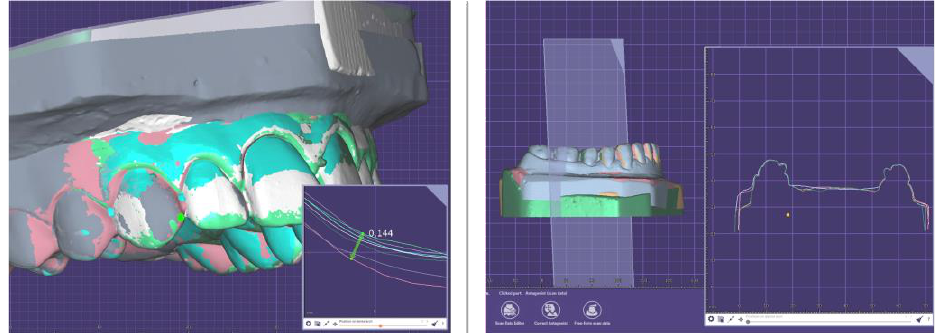
Figure 4. DentalCAD 3.0 Galway (exocad GmbH, Darmstadt, Germany) measurements on the digital study models .